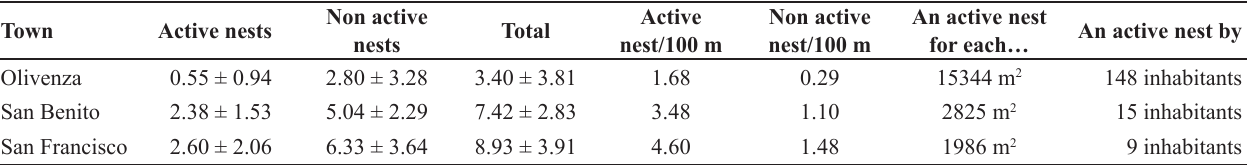
Table 2 . Average abundance of active and non-active nests in the localities studied and relative abundance of nests with respect to the urban area and the number of inhabitants.